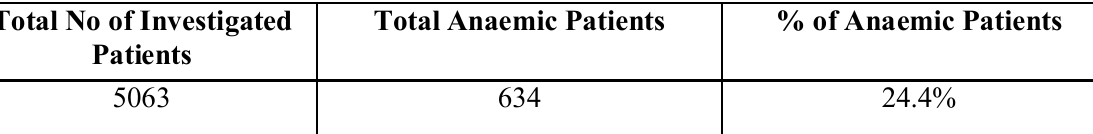
Table:2 reperesents the status of anaemia